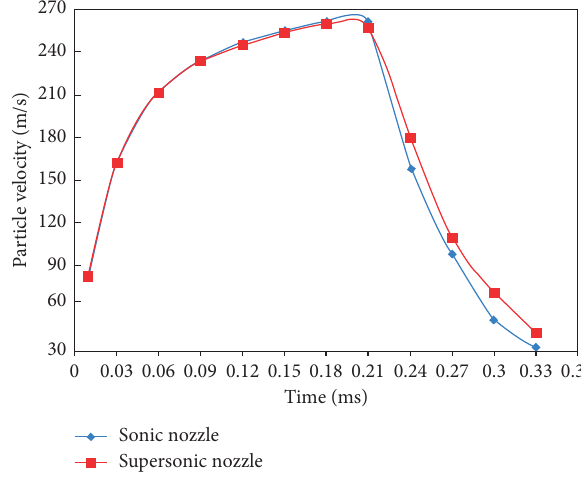
Figure 11: Particle velocity inside the driven section.